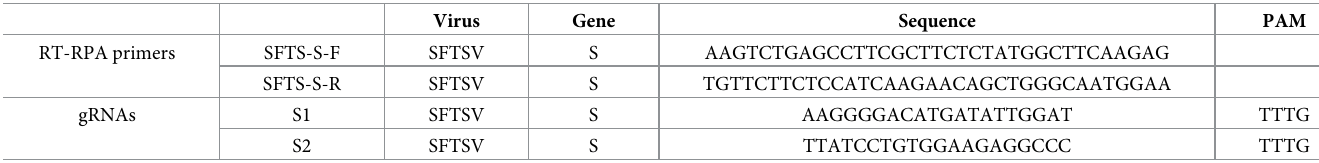
Table 1. RPA primers and gRNAs for SFTSV